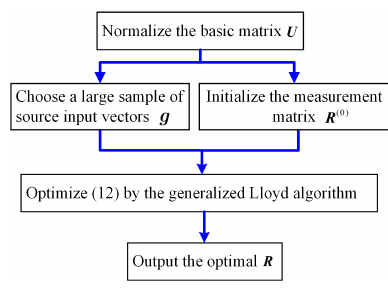
Figure 2. Flowchart of the proposed optimal search method for measurement matrix.